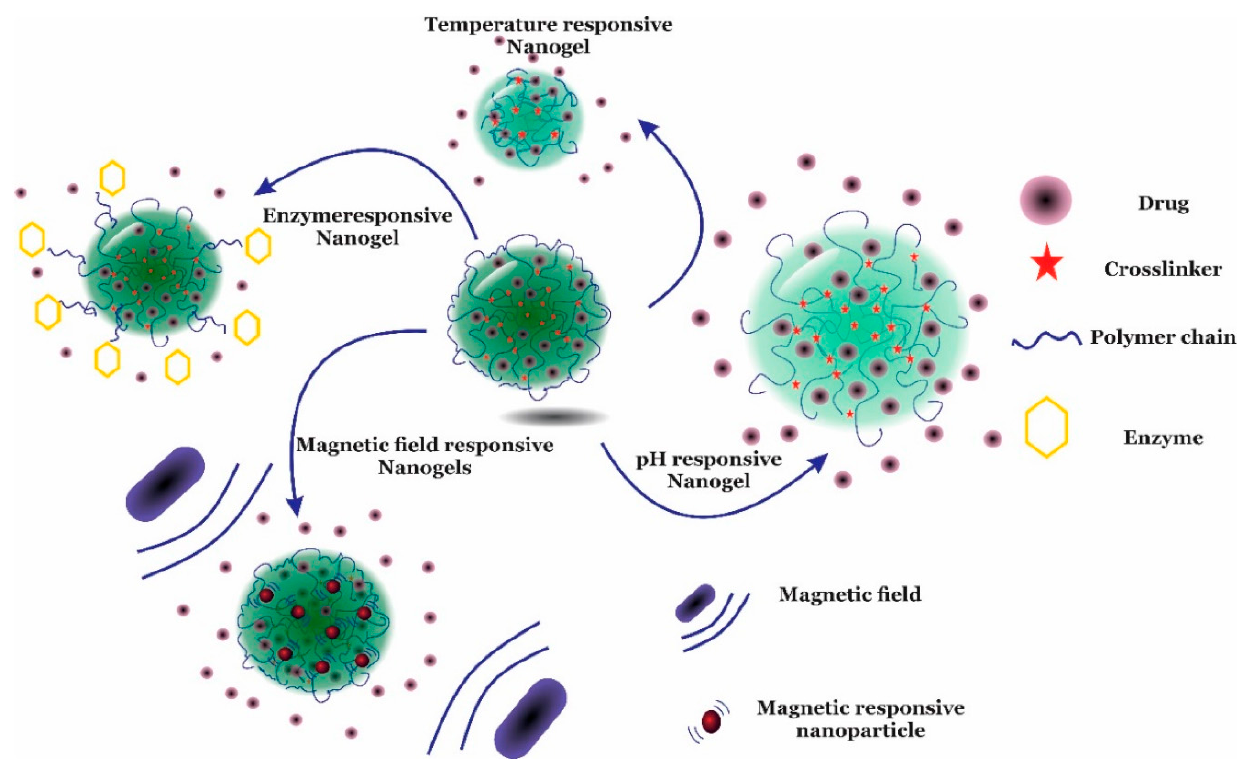
Figure 3. Schematic illustration of the release of drugs from a nanogel triggered by different stimuli such as temperature, enzyme, magnetic fields redox potential and pH [65].